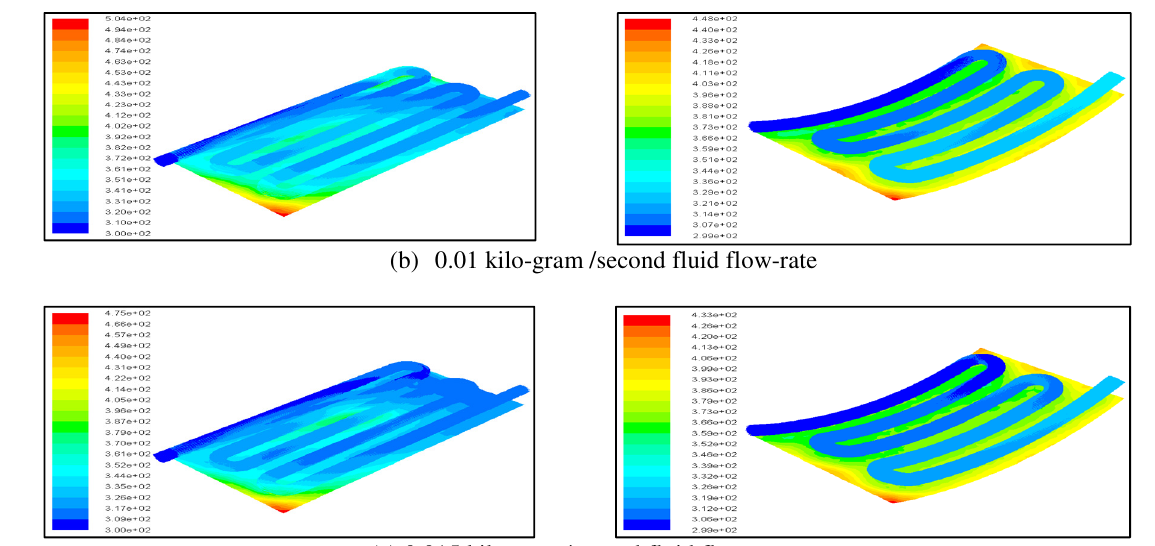
Fig. 6: Temperature Contours of SFPC and SCPC for Chongqing City